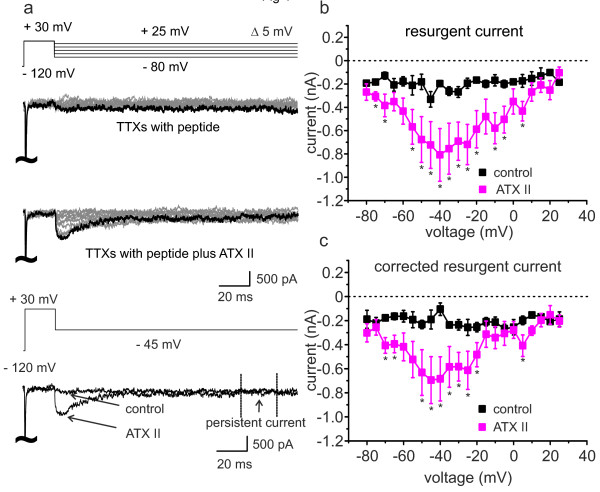
ATX-II induces resurgent currents in small diameter DRGs with the β4-C-terminus peptide in the pipette solution. (a) Voltage protocol (top panel) and representative current traces of recordings from small diameter DRGs with the β4-peptide added to the pipette solution. Lower lane shows an overlay of recordings from control and ATX-II (5 nM) treated cells at −45 mV. (b) TTXs peak current within the first 10 ms after repolarization of control (black symbols, n = 4) and ATX-II exposed (pink symbols, n = 6) small DRGs. Under ATX-II exposure a distinct resurgent current can be recorded, when the β4-peptide is present in the pipette solution. (c) The increase of resurgent current is not due to a persistent current component, as subtraction of the persistent current (determined at the end of the hyperpolarizing pulse, see lower panel in a) from peak current reveals a clear corrected TTXs resurgent current component. * p < 0.05, independent-sample T-test.